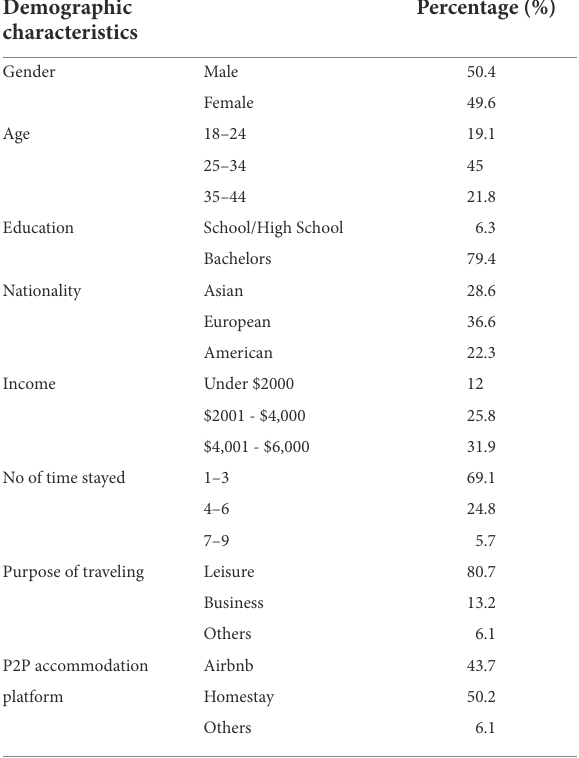
TABLE 3 Demographic characteristics of the